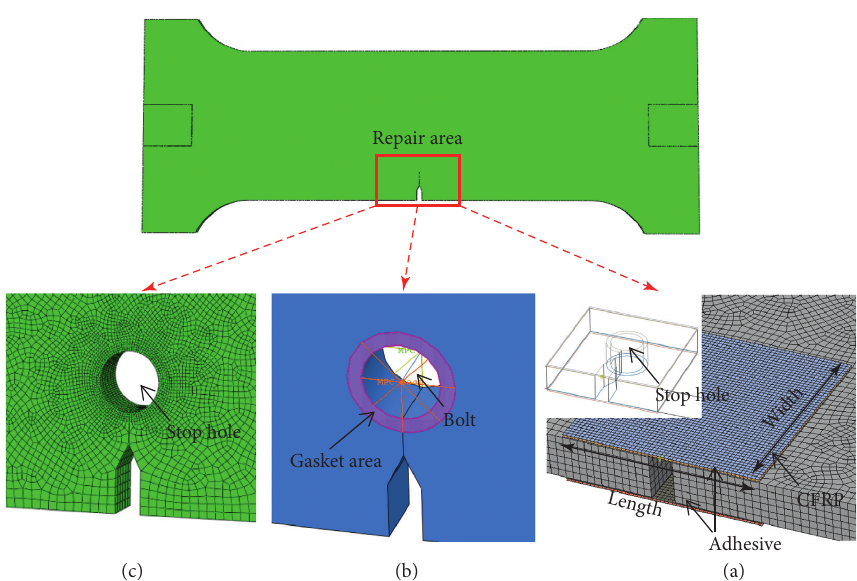
Figure 4: Numerical models of various strengthening method. (a) Model 1. (b) Model 2. (c) Model 3.